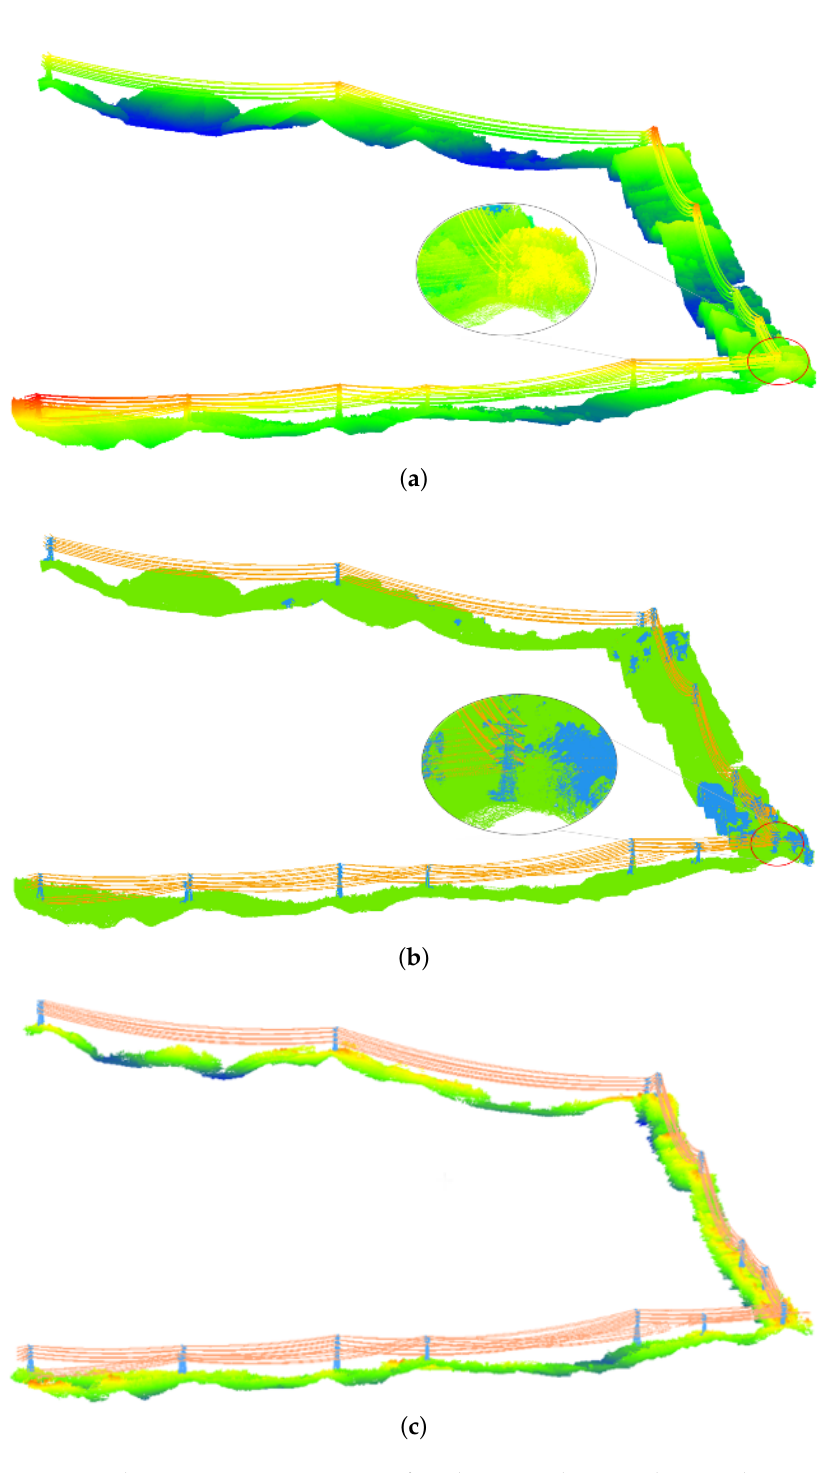
Figure 17. The main extraction process of 220 kV power lines in a large-scale scene. ( a ) The original scene of the power lines rendering according to the elevation. ( b ) The coarse extraction results. The orange points represent the power line points, and the blue points represent the pylon points. ( c ) The safety distance result of the ground points. The ground points from blue to red indicate that the points are getting closer to the